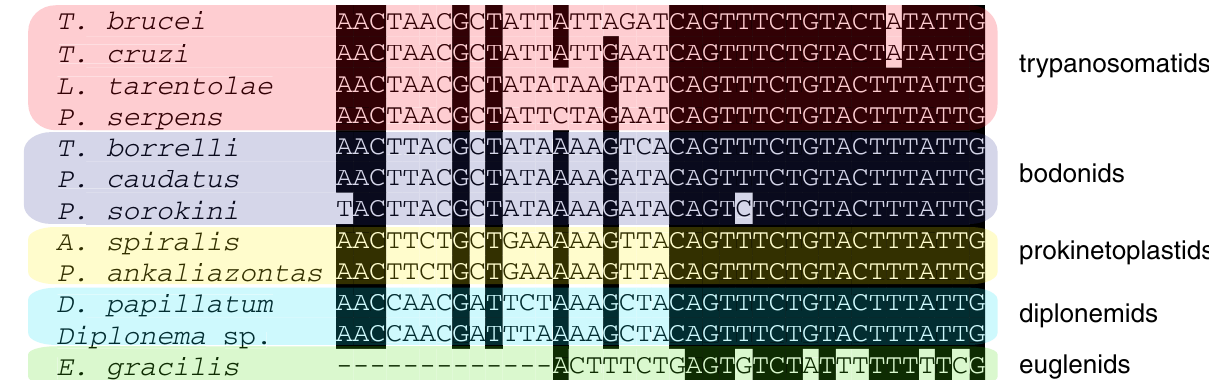
Figure 6. Most prokinetoplastid transcripts contain a spliced-leader (SL) motif similar to those found in other euglenozoans. These sequences are similar to those of SLs from a wide variety of euglenozoans, but are also distinct. The distinctions help to confidently differentiate bona fide prokinetoplastid mRNAs from those of their prey, the bodonids Procryptobia sorokini and Parabodo caudatus . Background shading indicates ≥ 90% sequence